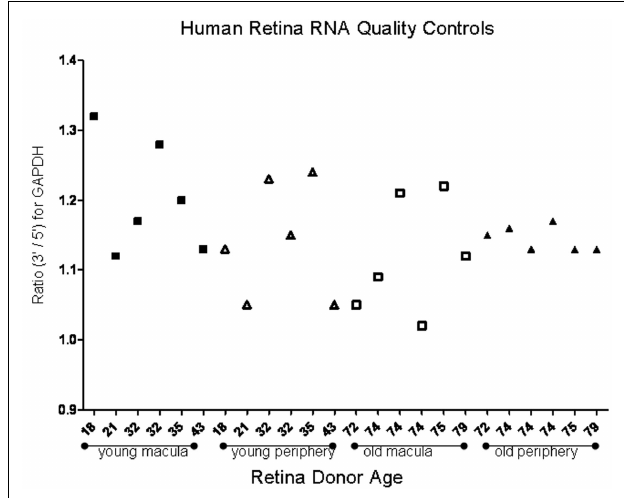
FIGURE 1 | Ratio of the 3 (cid:2) and 5 (cid:2) signal obtained from human house keeping gene GAPDH using microarray. Study was performed to assess mRNA quality isolated from human donor eyes.Young samples and older samples are presented in order of donor age for both macular and peripheral samples.There is no correlation between donor age and signal ratio.The average of 3 (cid:2) /5 (cid:2) signal ratio of all samples is 1.152 ± 0.07, which denotes good quality.